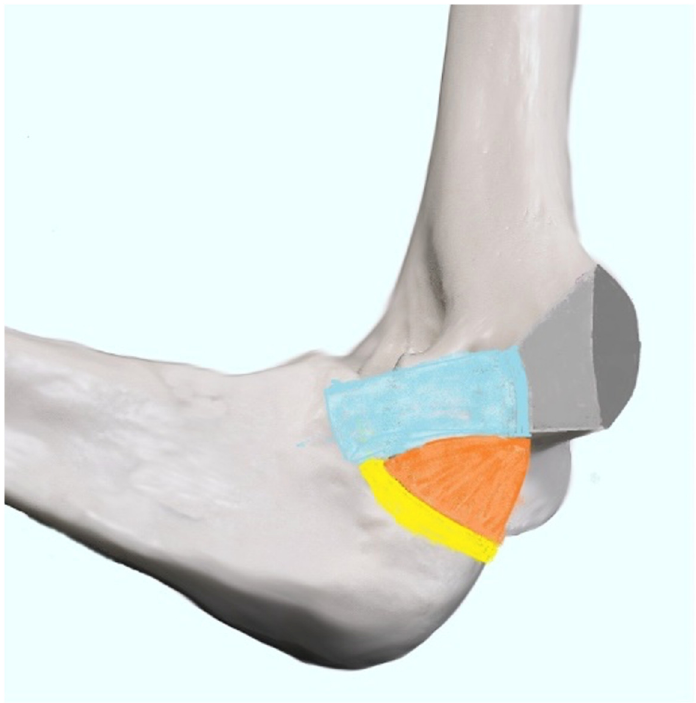
Figure 2. Anatomical diagram showing the site of typical attachment of flexors (CFT) and medial collateral ligament. A dark gray area represents the site of attachment of the superficial, less fibrotic part of the attachment of CFT; a light gray area—the site of attachment of a deeper, less fibrotic part of it; complex, blue—anterior part of the medial collateral ligament; orange—posterior part, with the transverse part’s attachment marked in yellow.